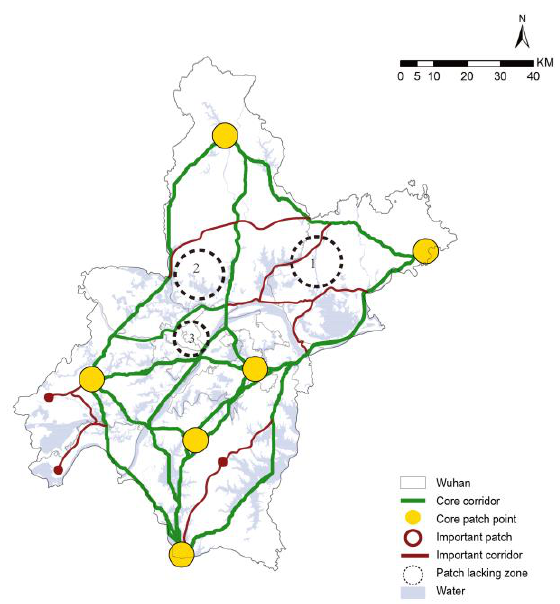
Figure 7. Integrated priority network planning.